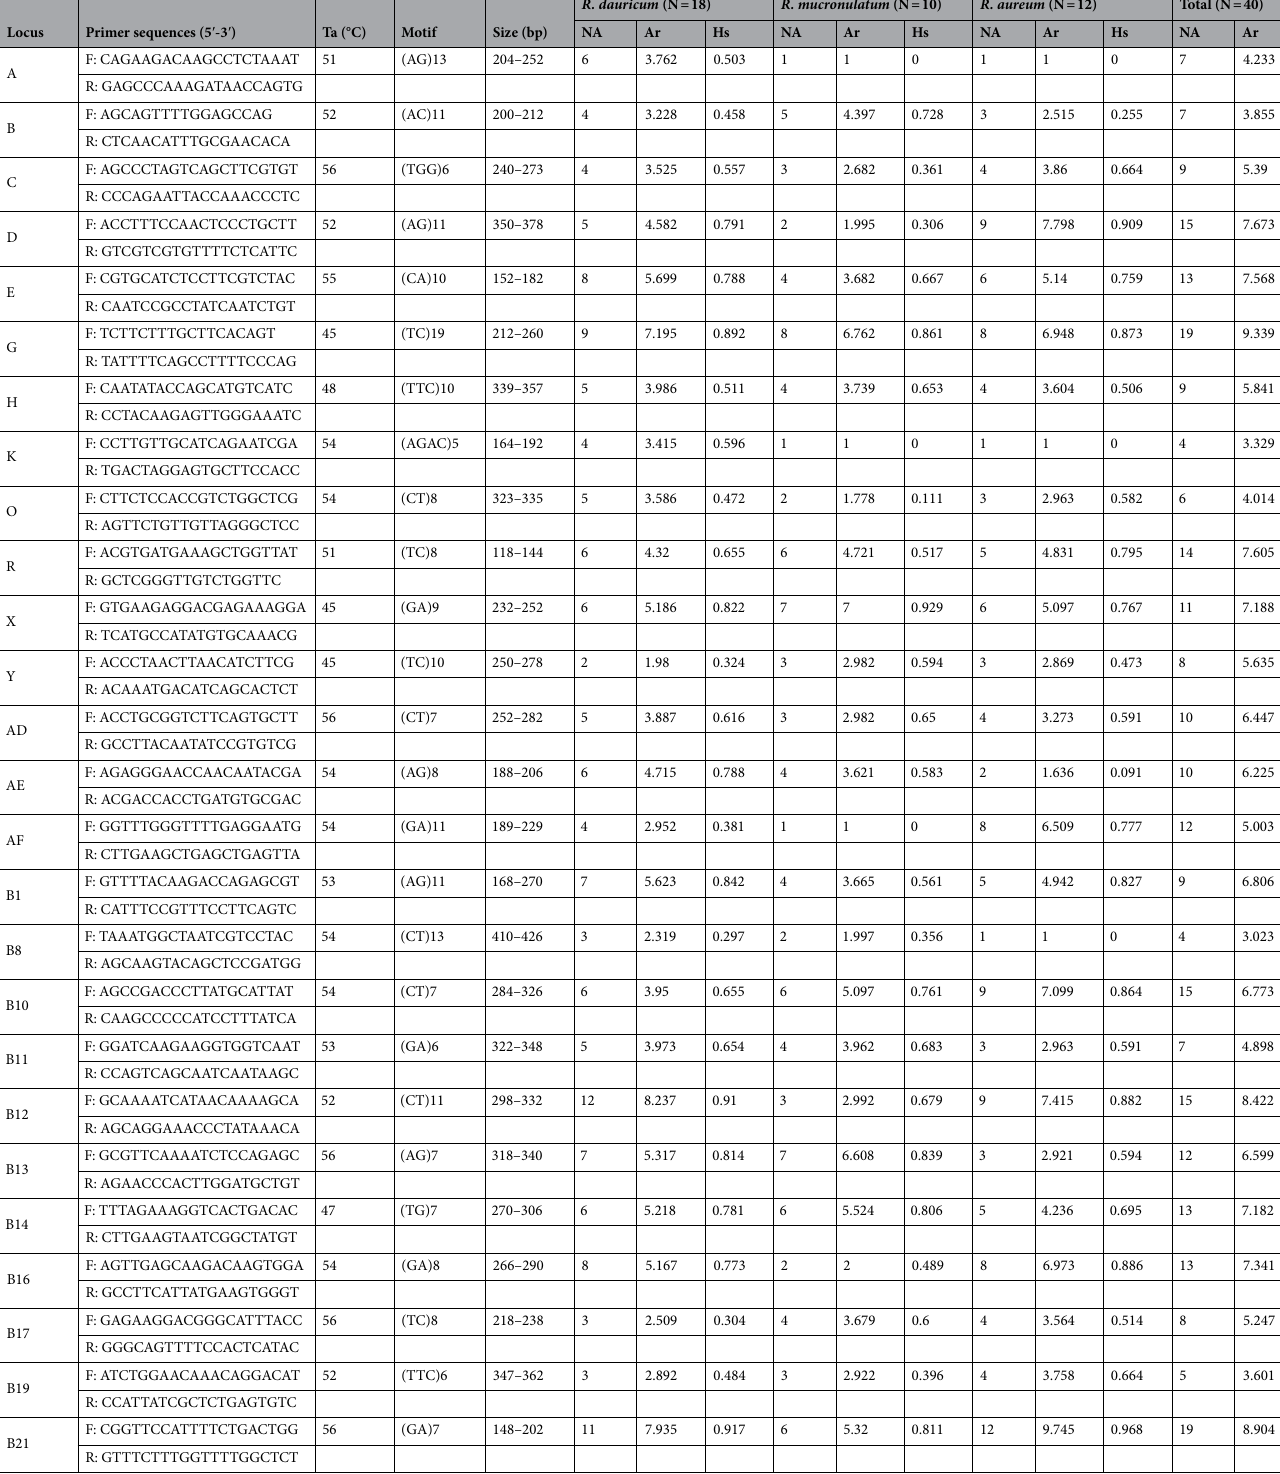
Table 1. Characteristics of the 26 loci developed for R. dauricum and R. mucronulatum